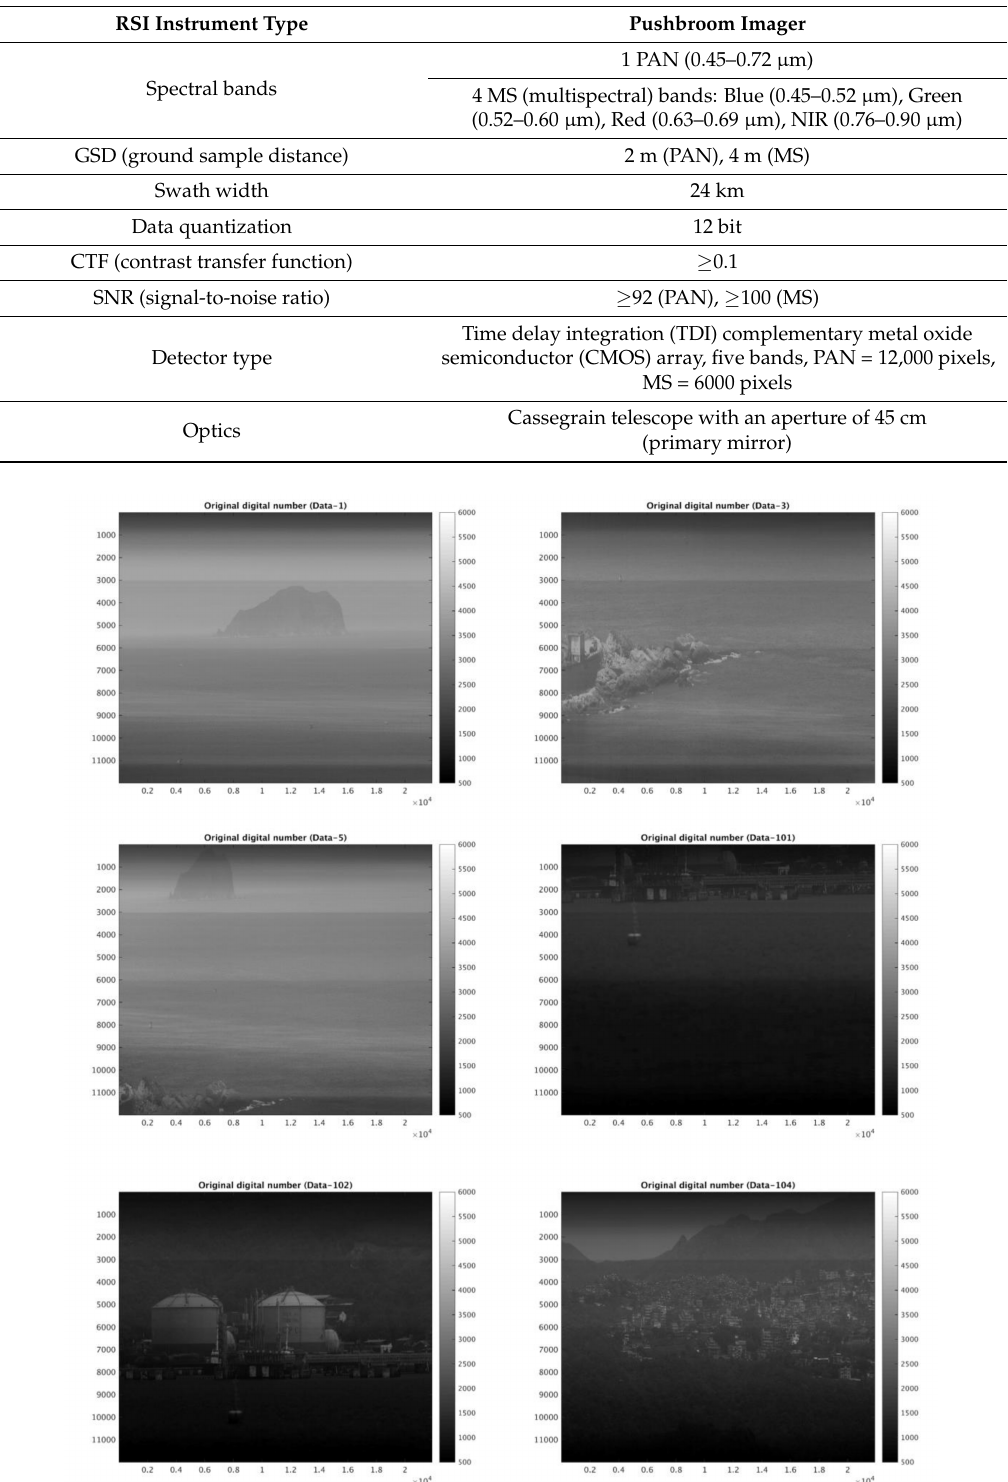
Table 1. The specification of the FORMOSAT-5 remote-sensing instrument (FS-5 RSI) sensor.